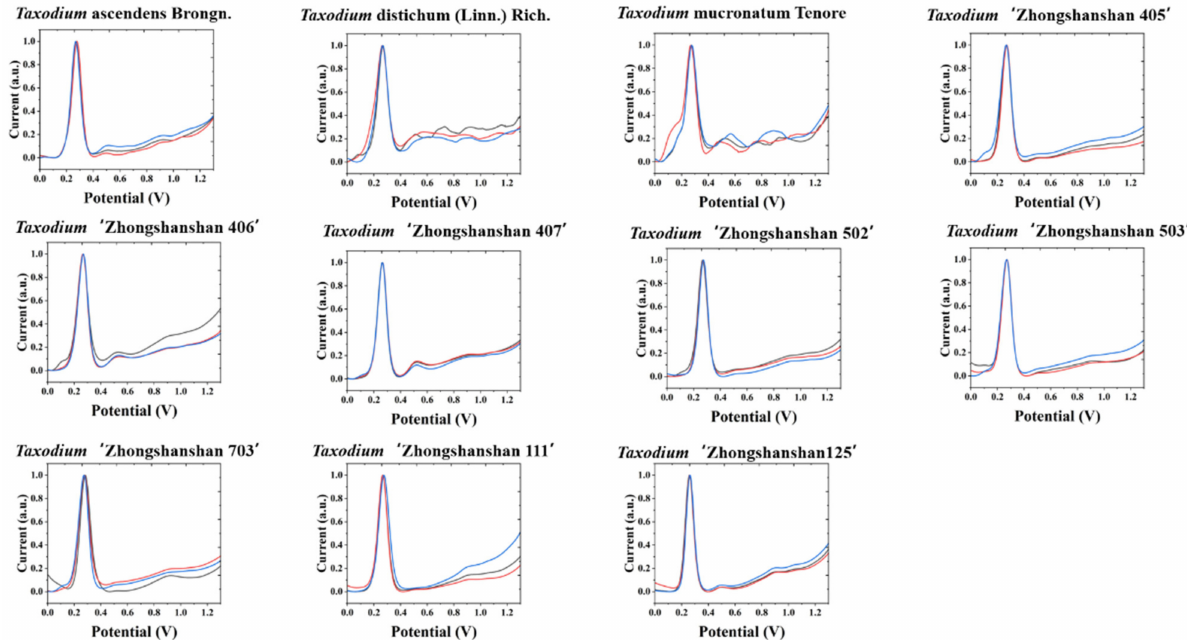
Figure 1. Electrochemical fingerprint of T. ascendens , T. distichum , T. mucronatum , T. ‘Zhongshanshan 405’, T. ‘Zhongshanshan 406’, T. ‘Zhongshanshan 407’, T. ‘Zhongshanshan 502’, T. ‘Zhongshanshan 503’, T. ‘Zhongshanshan 703’, T. ‘Zhongshanshan 111’, and T. ‘Zhongshanshan 125’ after water extraction and recorded under PBS condition.